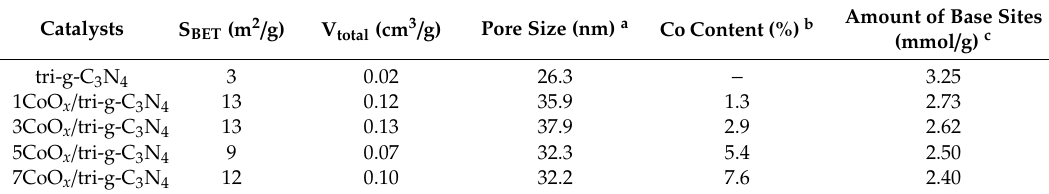
Table 1. Textural and basic properties of tri-g-C 3 N 4 and CoO x / tri-g-C 3 N 4 .